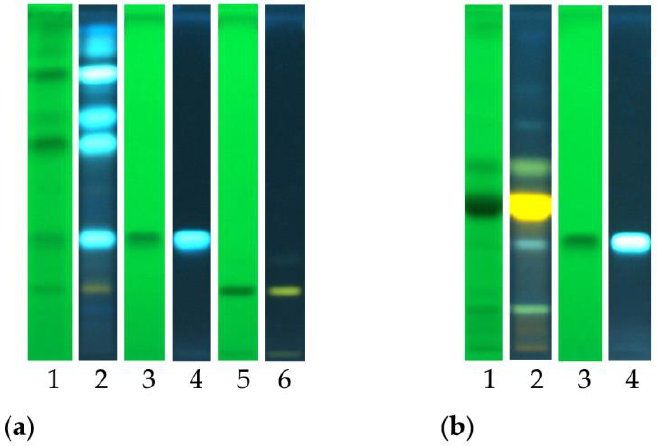
Figure 2. High-performance thin-layer chromatography (HPTLC) fingerprints of ( a ) C. ruber (L.) DC. and ( b ) T. majus L. ethyl acetate fractions. Mobile phase: Ethyl acetate/dichloromethane/acetic acid/formic acid/water (100:25:10:10:11, v/v/v/v/v). Tracks: 1, sample visualized at 254 nm; 2, sample at 366 nm and NP derivatization; 3, chlorogenic acid ad 254 nm; 4, chlorogenic acid at 366 nm; 5, rutin at 254 nm; 6, rutin at 366 nm.